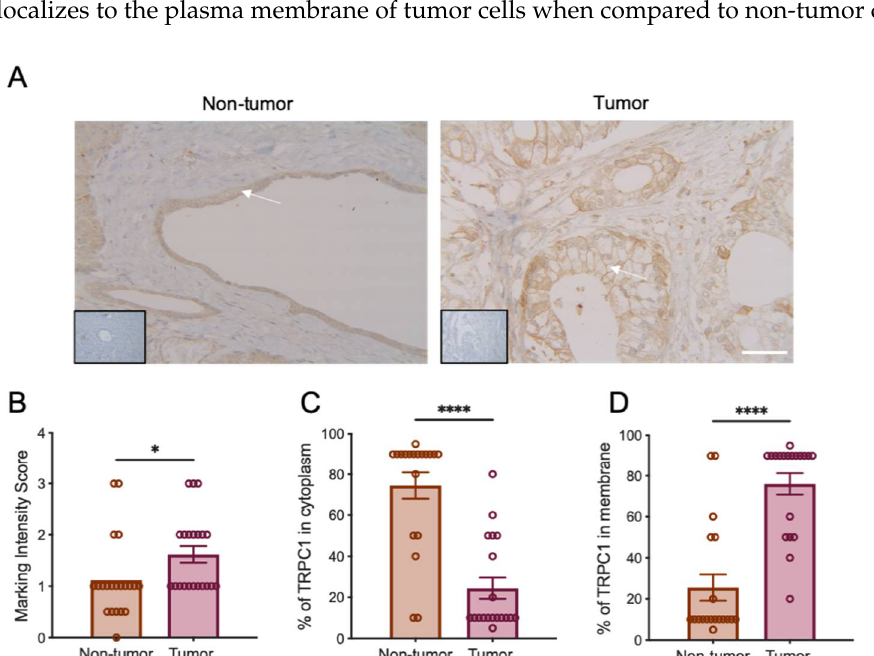
Figure 2. TRPC1 is overexpressed in PDAC tissue and cell lines, where it localizes to the plasma membrane. ( A ) Representative images of TRPC1 expression in human PDAC tissue, performed by immunohistochemistry (IHC). White arrows indicate expression in the cytoplasm (left panel) and the plasma membrane (right panel). Inserts represent negative controls, scale bar = 40 µm. ( B ) Quantification of TRPC1 marking intensity score between non-tumor and tumor tissue (N = 21). ( C ) Quantification of TRPC1 expressed in the cytoplasm and ( D ) membrane (N = 21). ( E ) Western blot analysis (left panel) and quantification (right panel) of TRPC1 expression in commercial-available PDAC cell lines ( n = 3–5). ( F ) Representative immunofluorescent analysis of TRPC1 in HPNE and PANC-1 cells ( n = 3), scale bar = 20 µm. Welch’s correction t-test was used to determine the significant difference between control and tumor conditions. *, *** and **** indicate p < 0.05, 0.01, 0.001, and 0.0001, respectively. 2.3. The Knockdown of TPRC1 Inhibits PANC-1 Cell and Spheroid Growth To study the role of TRPC1, we validated our knockdown (KD) model (Supplementary Figure S1). TRPC1 protein expression decreased by 44 ± 10% after 72 h of siRNA transfection against TRPC1. Similar results were obtained by assessing the TRPC1